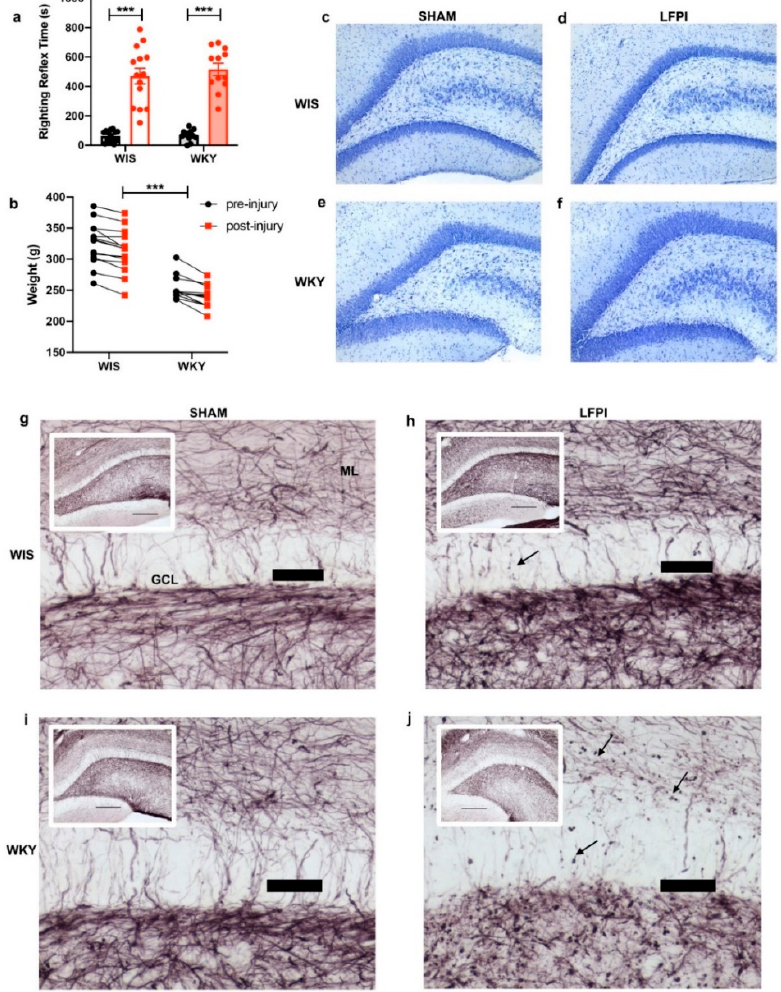
Figure 2. Equivalent injuries were produced in WIS and WKY animals, although WKY showed exaggerated myelin changes. ( a ) Injured animals (red bars) in both the WIS and WKY group had increased righting reflex times immediately after injury compared with the sham (black bars) animals. There was no statistically significant effect of strain. ( b ) All of the injured animals showed a decrease in weight on the post-injury day. Repeated measured ANOVA showed a significant effect of injury and additionally an effect of strain. As illustrated, the age-matched WKY animals had significantly lower pre-injury weights. ( c , d ) The WIS animals did not show large lesions in the dentate gyrus with injury, nor did the WKY ( e , f ) animals. ( g ) The WIS sham animals showed a normal pattern of myelination in the dentate gyrus granule cell layer (GCL) and molecular layer (ML). ( h ) Three weeks post-injury the WIS animals showed signs of myelin loss, including areas of punctate staining (arrow). ( i ) The WKY animals also showed a normal myelination pattern. However, the WKY injured animals ( j ) showed an extensive decrease in myelin staining and exaggerated punctate staining (arrows). Insets ( g – j ) show low power (10 × objective) images of gold chloride stained dentate gyrus, scale bar = 250 µ m. Scale bars ( g – j ) = 50 µ m. *** p <